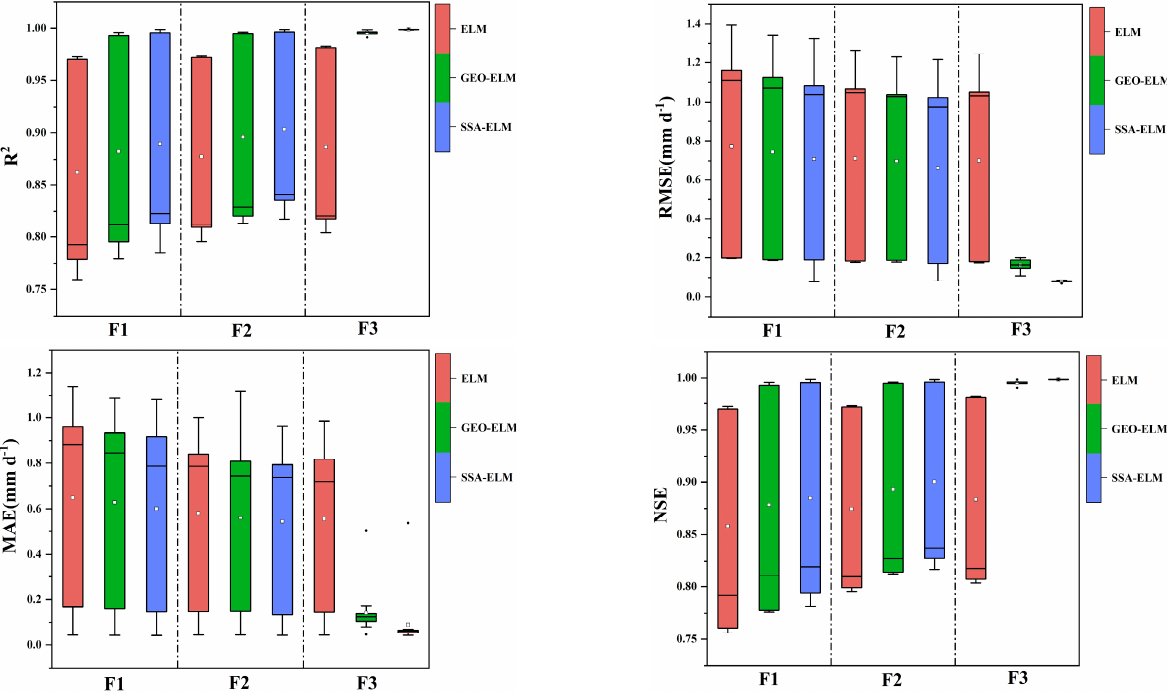
Figure 6. Performance of the three ET O models. Table 2. Statistical values of the three ET O models with different input parameters.